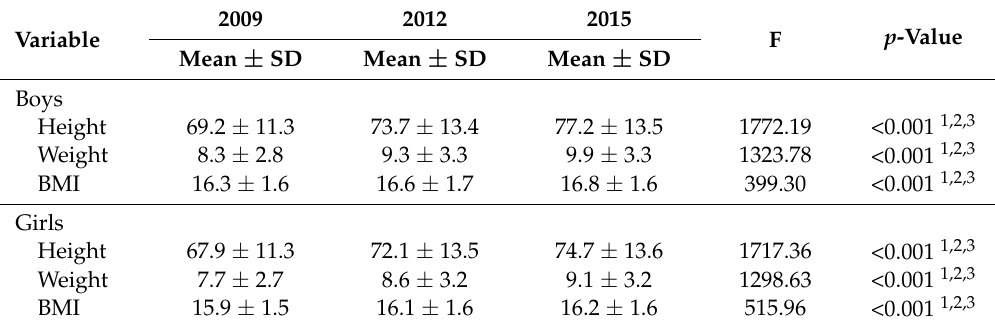
Table 2. Age-adjusted means and standard deviations for height, weight, and BMI in boys and girls (0–5 years old) by year of